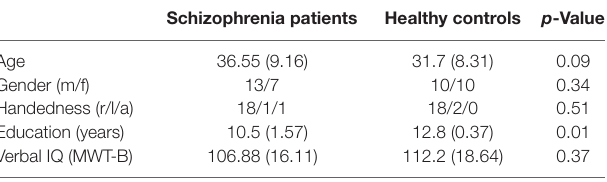
TaBlE 1 | Group demographics. Schizophrenia